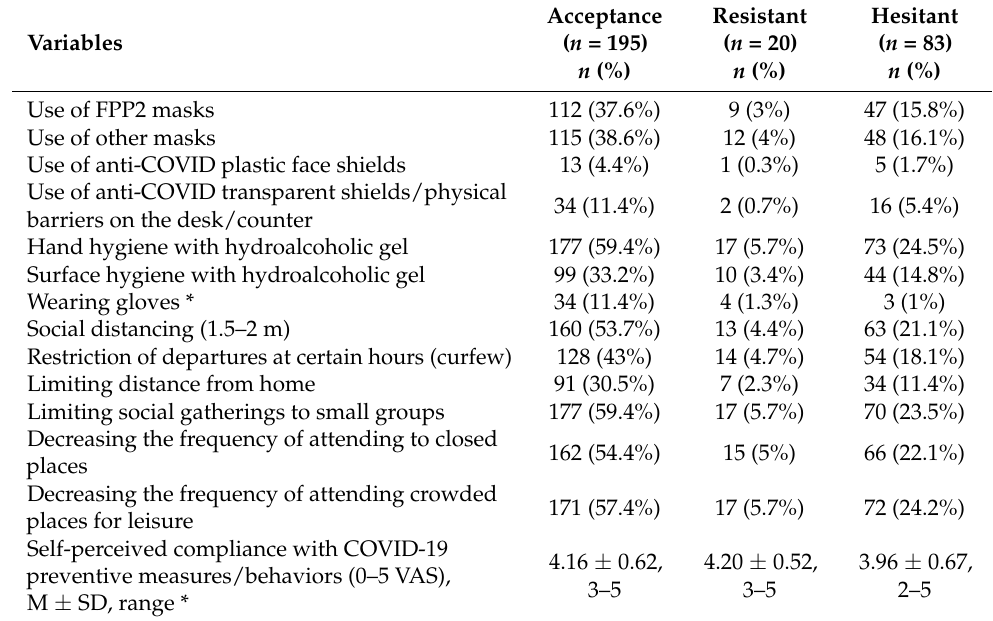
Table 3. COVID-19 preventive measures/behaviors ( N = 300) a